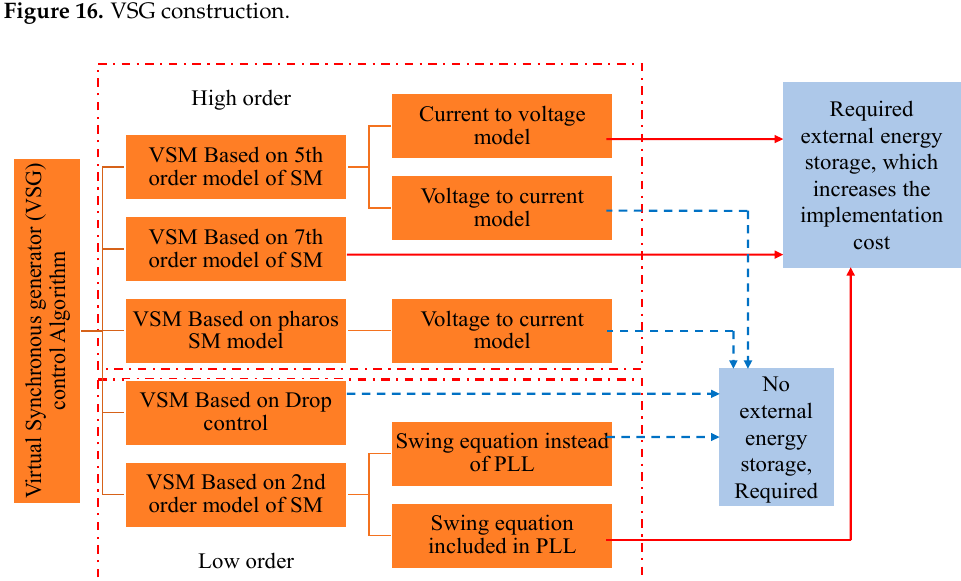
Figure 17. VSG classification according to model order [42].